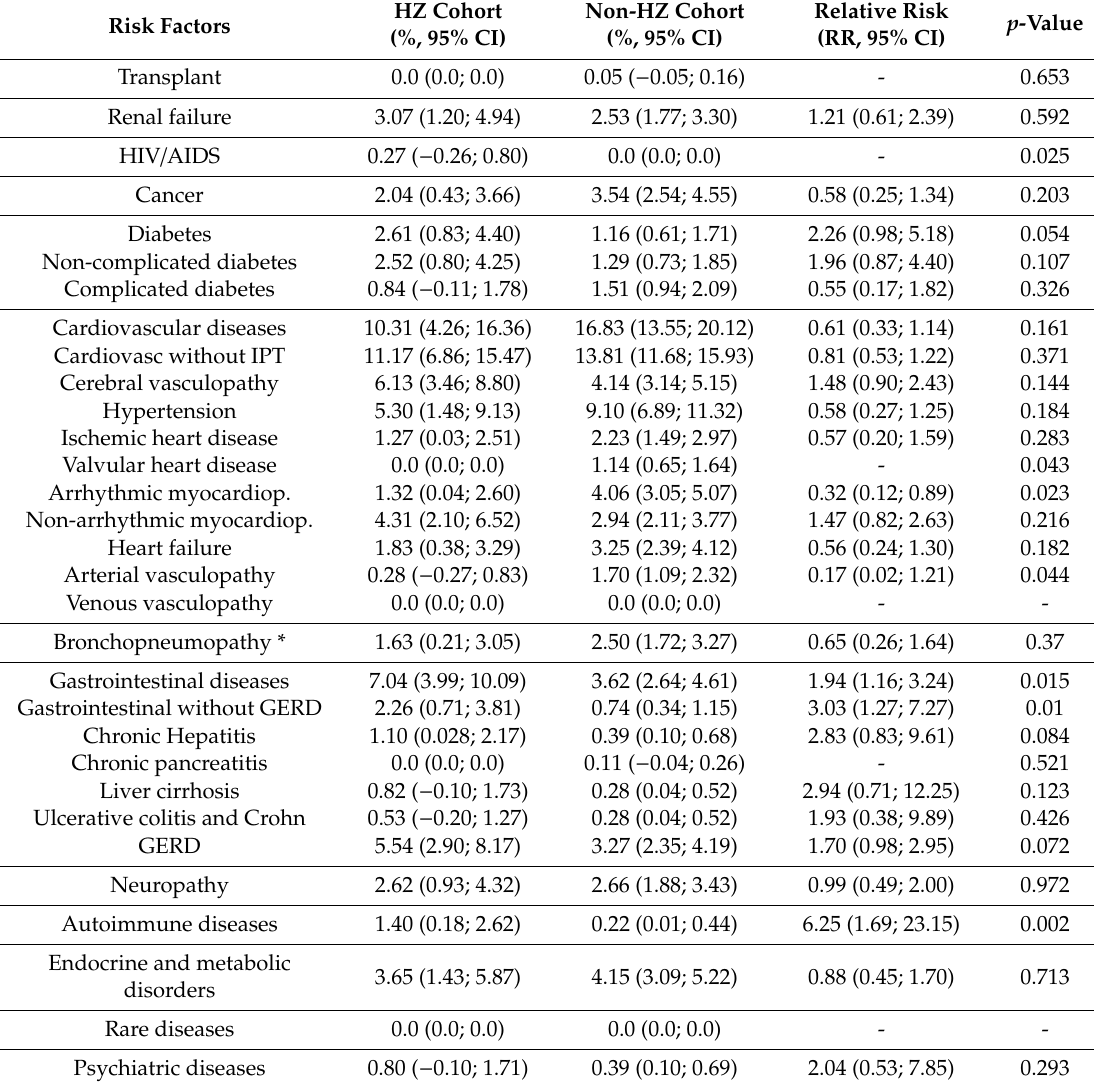
Table 2. Cumulative incidence rate of chronic diseases during the 6 months after hospitalization in the HZ cohort and non-HZ cohort; period